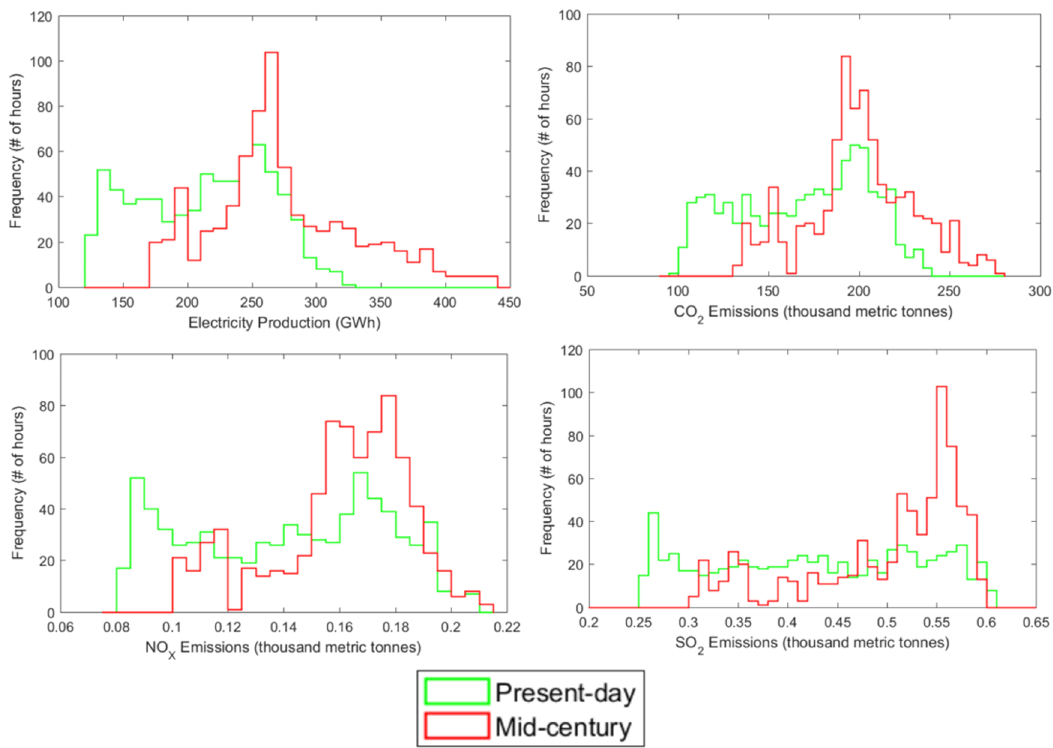
Fig 3. Histograms of hourly electricity production and emissions. Histograms are provided for regionally summed hourly electricity production, CO 2 emissions, nitrogen oxide (NO X ) emissions, and SO 2 emissions for July in the present-day and warm mid-century warm climate scenarios. For electricity production: present-day mean: 212.9 GWh; minimum: 120.4; maximum: 320.3. Mid-century mean: 274.2 GWh; minimum: 172.0; maximum: 438.0. For CO 2 emissions: present-day mean: 168,800 tonnes; minimum: 99,800; maximum: 238,800. Mid-century mean: 200,100 tonnes; minimum: 132,700; maximum: 276,500. For NO